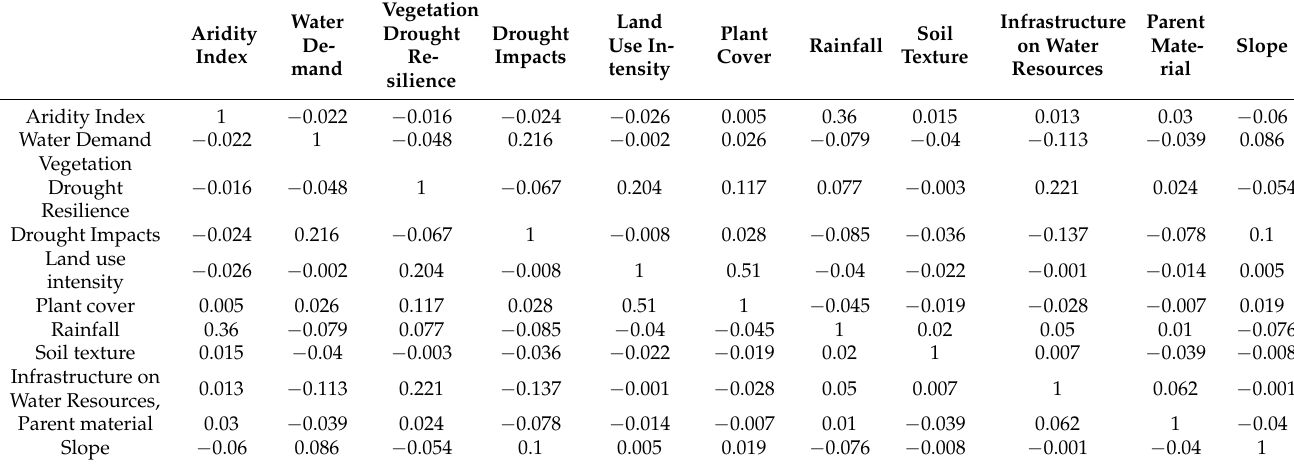
Figure 5. Examined indicators of SDVI for WLDI development and application. Table 2 shows the correlations of the selected components of PCA between the selected indicators of Water and Land resources Degradation Index. It is noted that all indicators portray a low correlation between them. According to the results of Table 2, there is a relationship between Aridity Index and rainfall, Water Demand and Drought Impacts, Drought resilience and Infrastructure on Water Resources, Land Use intensity, and Plant Cover. These values are low due to fact that the analyses are on a spatial basis. Table 2. Correlations between all indicators from the two complex